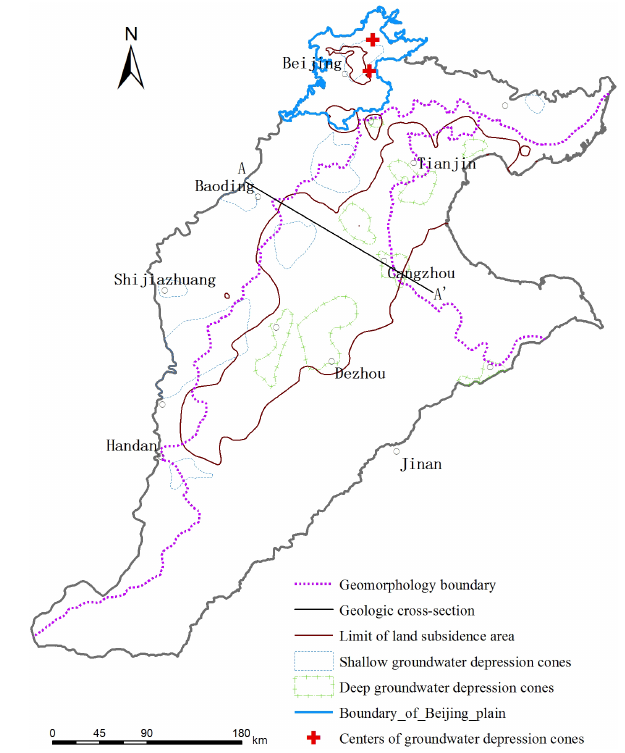
Figure 1. Distribution of the depression cones of shallow and deep groundwater, and major land subsidence area in the